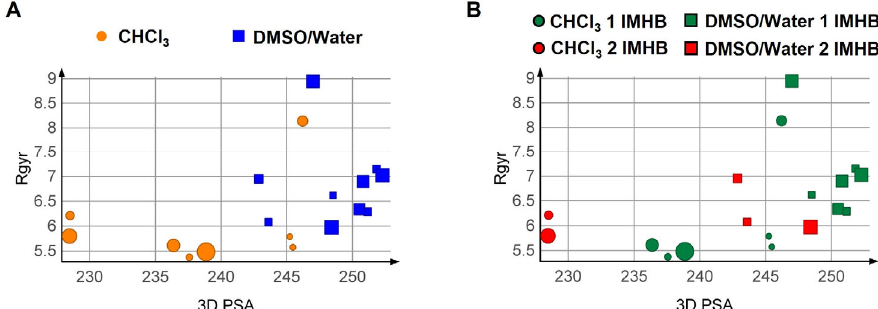
Figure 2. R gyr plotted vs. 3D PSA for the NMR ‐ derived solution conformations of PROTAC ‐ 1. ( A ) Colour and shape by solvent, ( B ) colouring by nIMHBs. The marker shape indicates the solvent and the size of the relative population in %.